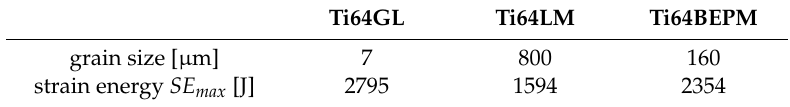
Table 4. Dependency between SE max parameter and β -grain size of the tested Ti64 alloys.